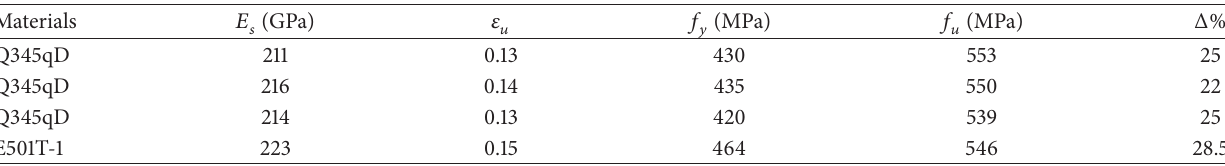
Figure 3: Selected welding seams with different widths. Table 1: Material properties.